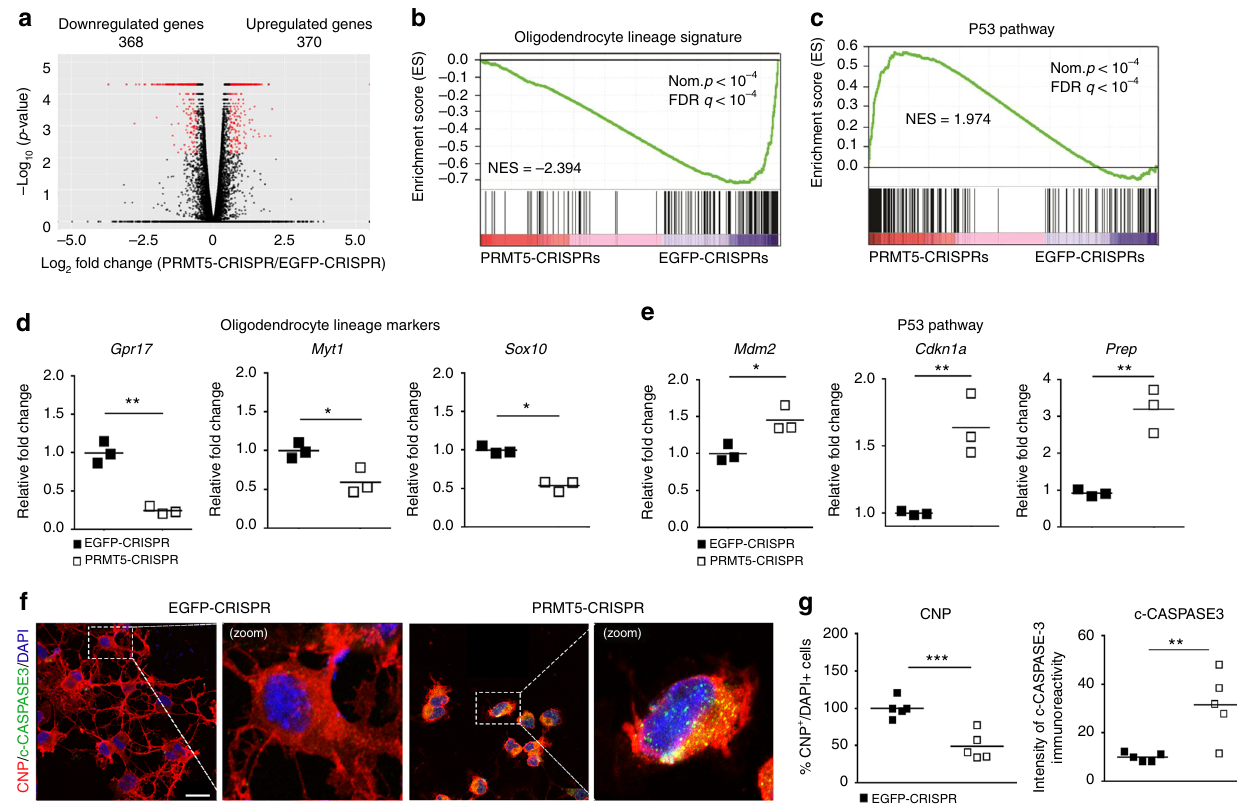
Fig. 4 Transcriptional consequences of decreased PRMT5 expression, using CRISPR/Cas9. a Volcano plot representing gene expression differences in OPCs between PRMT5-CRISPR knockdown and EGFP-CRISPR controls. Each gene is represented by a dot with the red dots indicating the differentially expressed transcripts that are statistically signi fi cant (fold change >1.5, FDR q value <0.05). b , c Gene set enrichment analysis (GSEA) identi fi ed b oligodendrocyte-speci fi c genes as downregulated and c P53 targets genes as up-regulated upon PRMT5 knockdown. d , e qRT-PCR validation of representative genes in each category, including d oligodendrocyte lineage ( Gpr17 , Myt1 , and Sox10 ) and e P53 targets ( Mdm2 , Cdkn1a , and Perp ) genes. Transcripts were normalized to the geo-mean of three housekeeping genes ( 18s , Wdr33 , and Pja2 ). Scatter plots represent average values of three independent preparations relative to controls. Student ’ s t test, * p < 0.05, ** p < 0.01. f Representative confocal images of control (EGFP-CRISPR) and knockdown (PRMT5-CRISPR) oligodendrocyte lineage cells cultured in differentiating conditions for 48 h and then stained with antibodies speci fi c for CNP (red), cleaved CASPASE-3 (c-CASPASE3, green), and DAPI (blue). Scale bar: 10 μ m. g Scatter plots represent average number of CNP + relative to total DAPI + cells and average intensity of cleaved CASPASE-3 staining in fi ve wells from three independent biological replicates in the PRMT5-CRISPR (418 total cells counted) group relative to the EGFP-CRISPR control group (428 total cell counted). Student ’ s t test, ** p < 0.01, *** p <